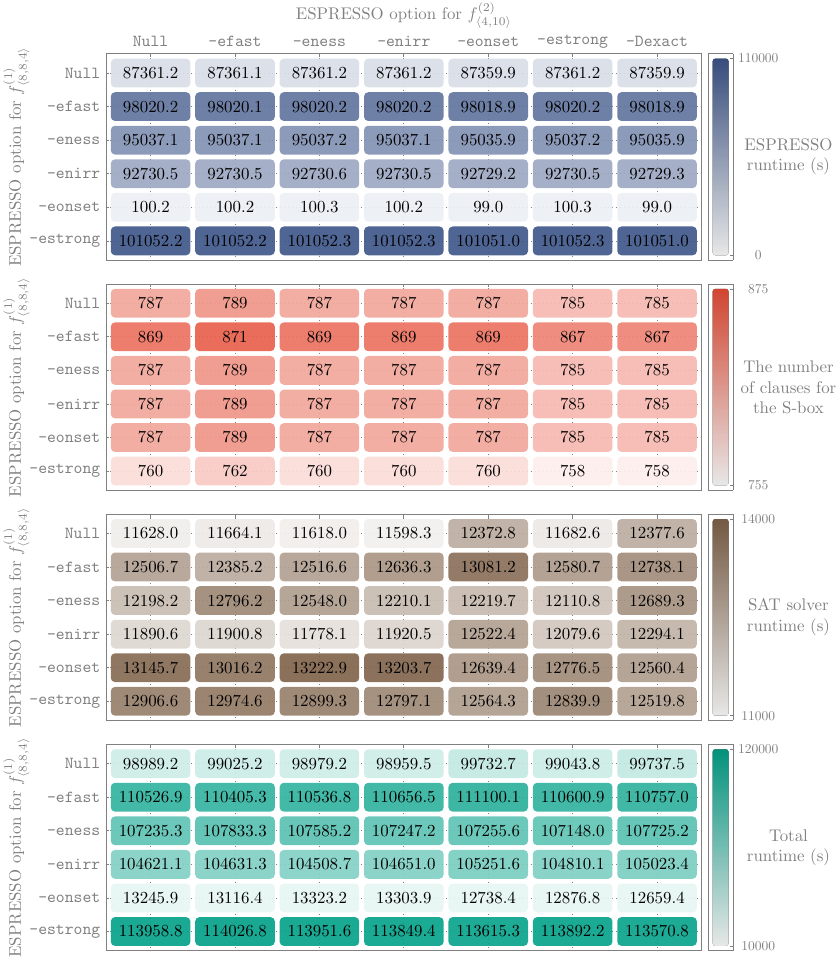
Figure 7: Test results for two-step encoding method regarding S